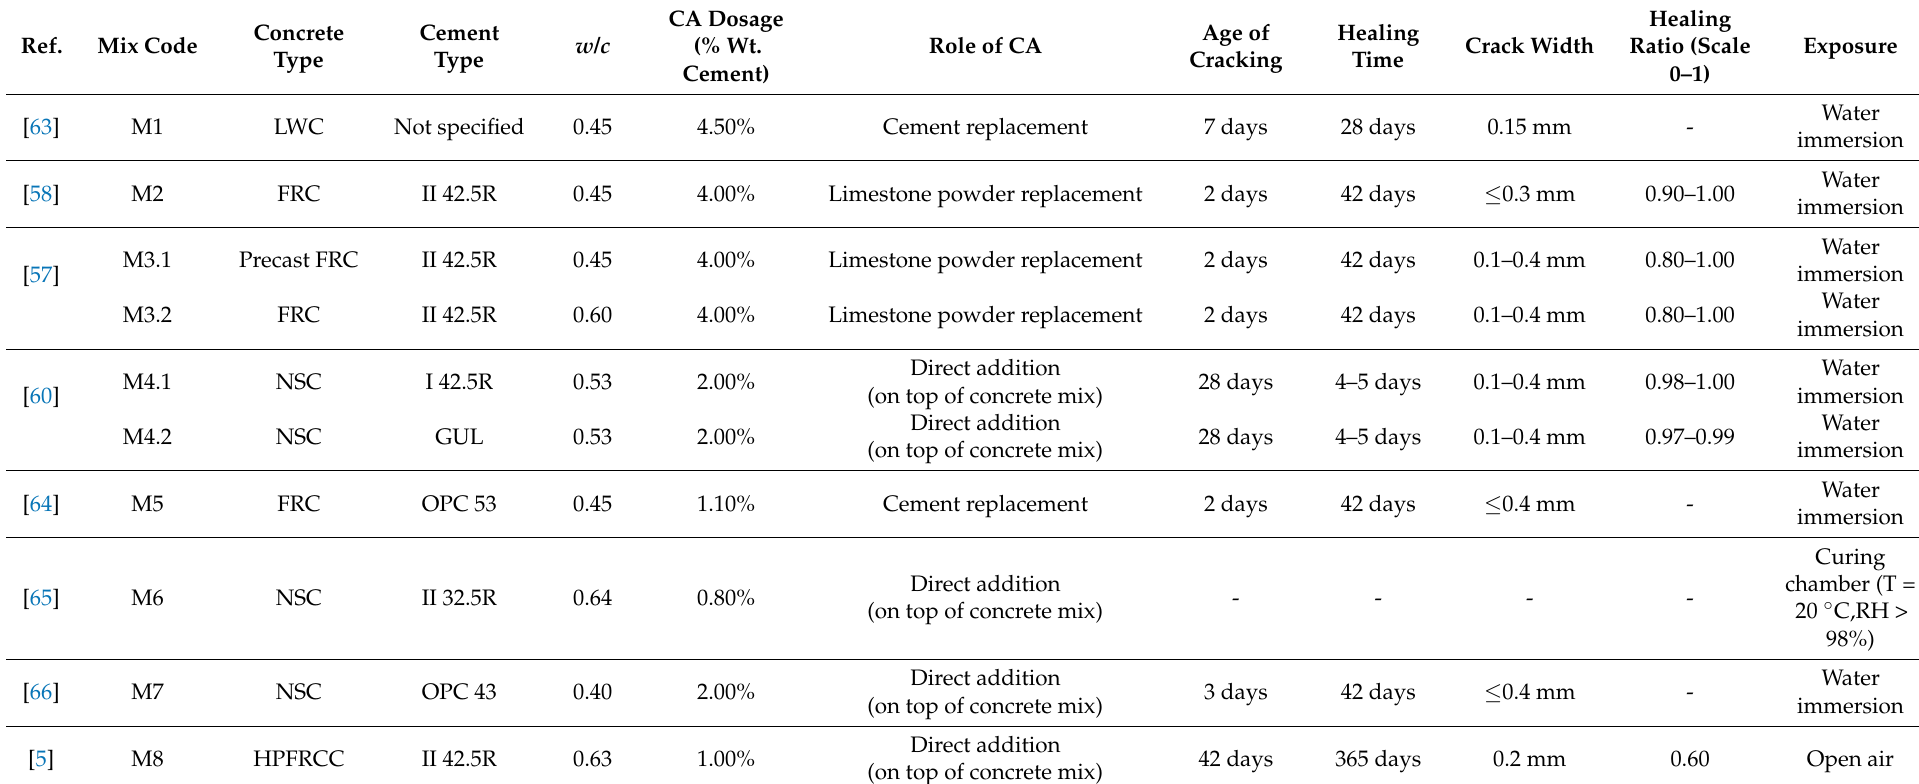
Table 3. Summary of CA concrete composition and the scenario of self-healing